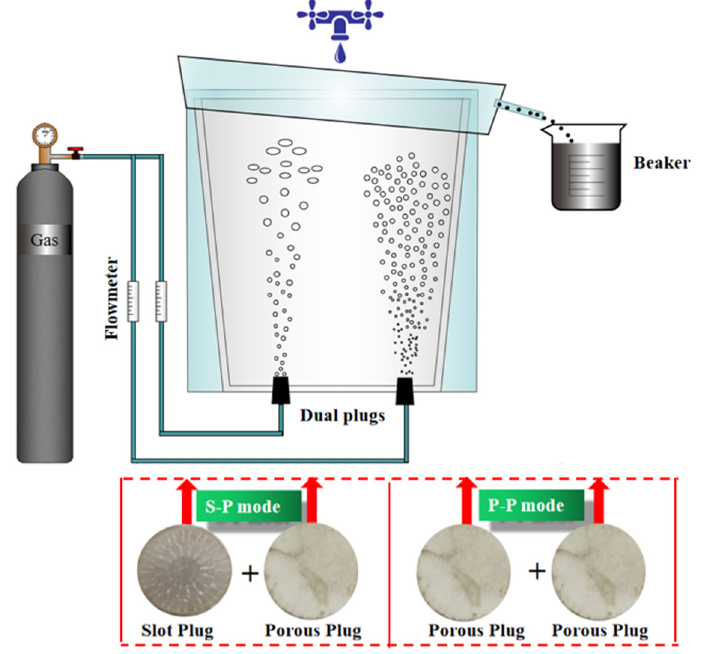
Figure 1. Con fi guration of water model experiment. Figure 1. Configuration of water model